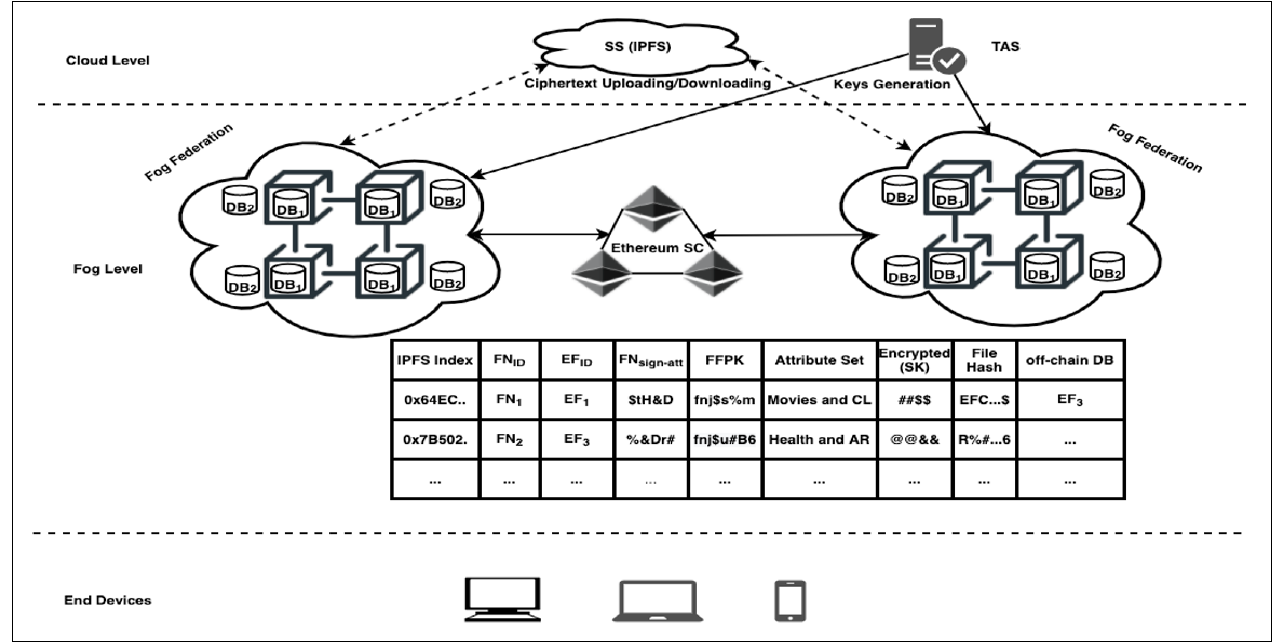
Figure 1. The proposed approach